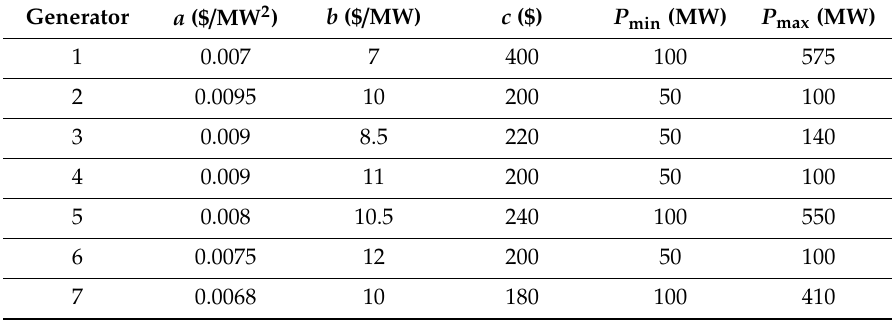
Table 1. Cost coe ffi cients of seven thermal units with lower and upper power limits.